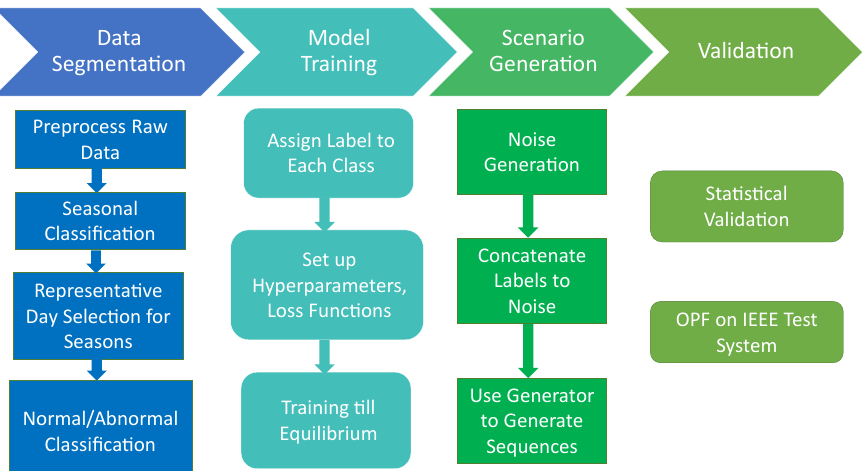
Figure 4. Flowchart of the proposed methodology. The first column captures the steps described in Section 2. The next two columns depict the training and use of the implicit generative model described in Section 3. The final column captures the thorough validation of the proposed methodology, which is described in Section